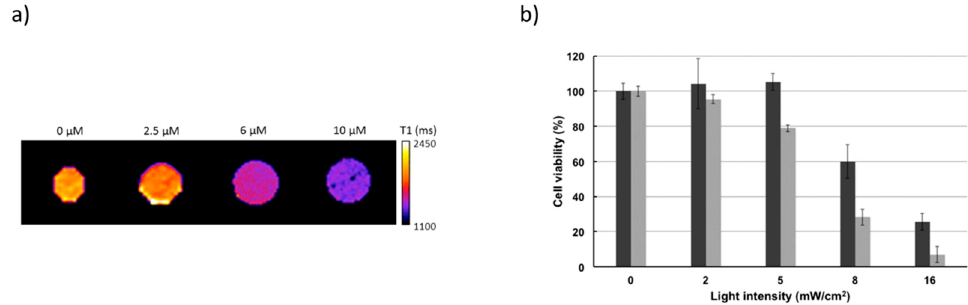
Figure 5. ( a ) T 1 maps of HeLa cell pellets at 7 T which were incubated for 24 h with different concentrations of the theranostic compound; ( b ) phototoxicity of the theranostic compound following 1 h irradiation at 636 nm after 24 h incubation at 2.5 μ M (dark gray) and 6 μ M (light gray). Adapted with permission from [51]. Copyright 2016 American Chemical Society.